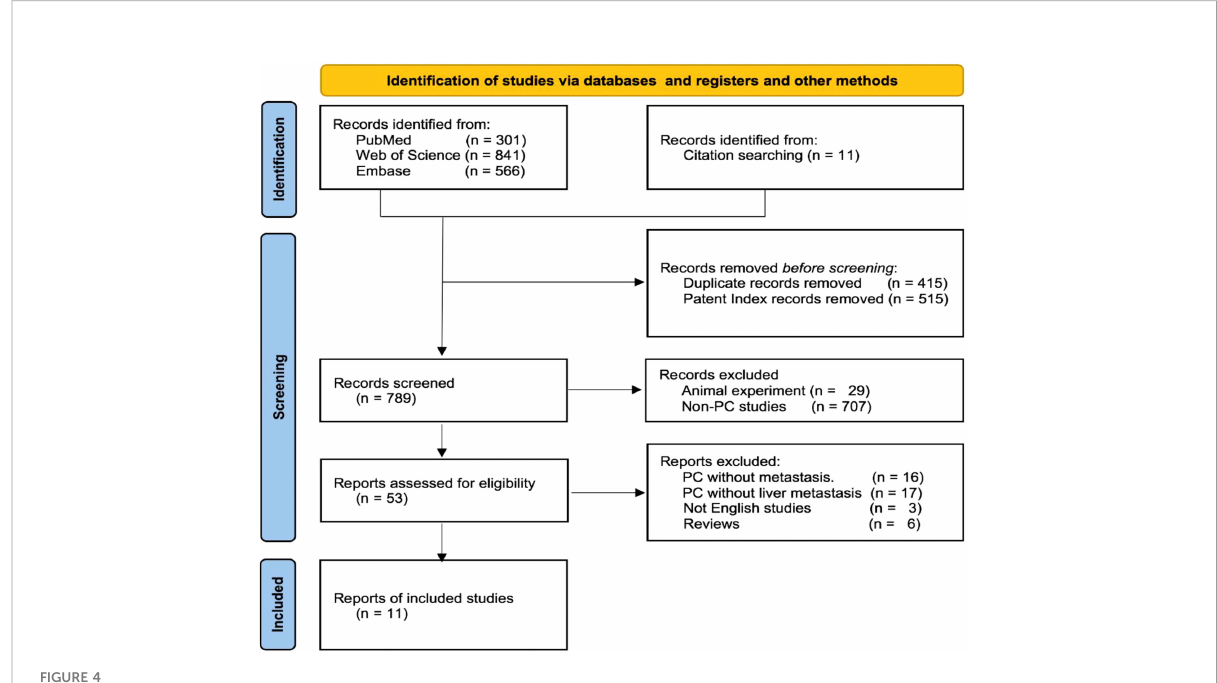
FIGURE 4 Flow of screening